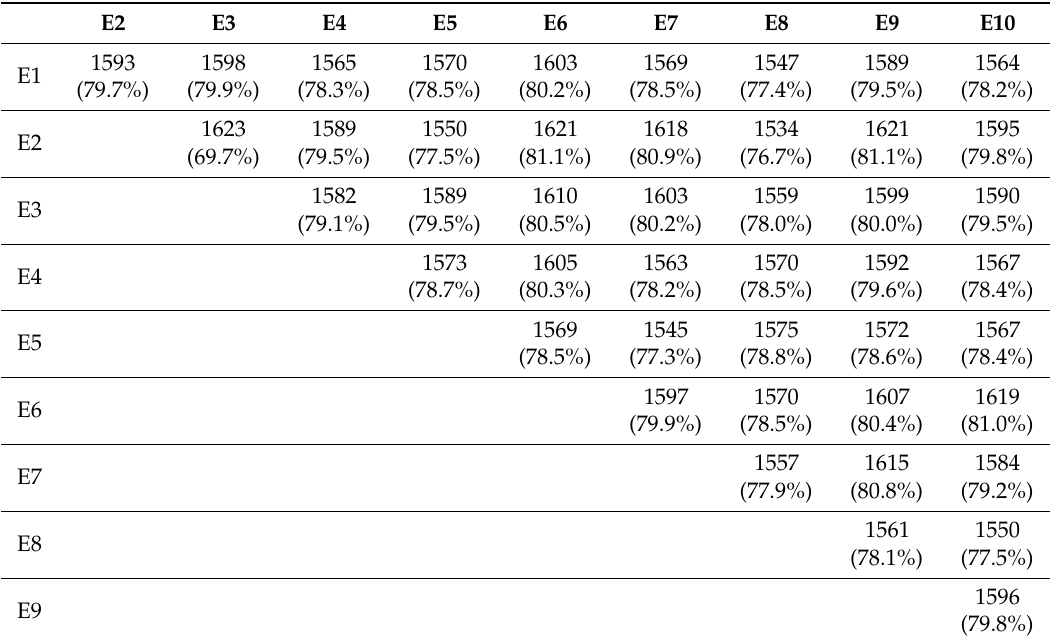
Table 4. The number of overlapped genes between the top 2000 genes of any two ranked lists obtained by